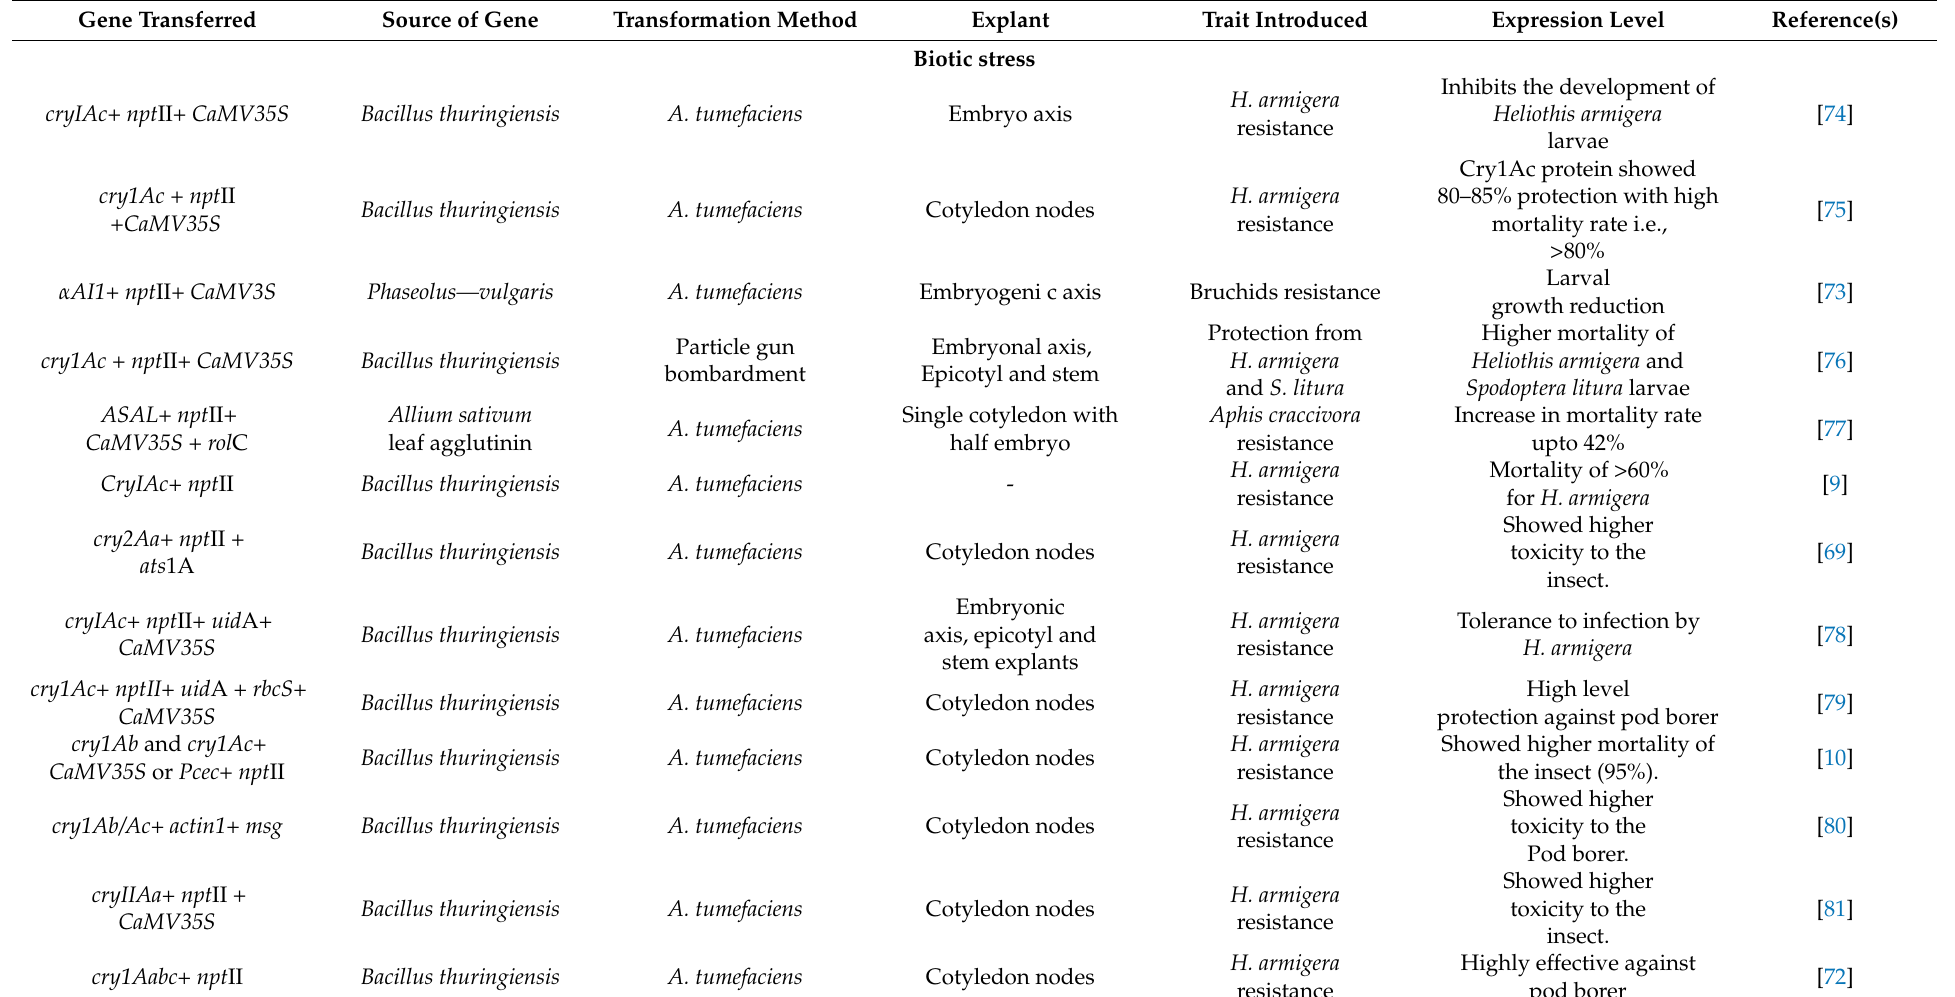
Table 3. Reports on crop improvement through transformation